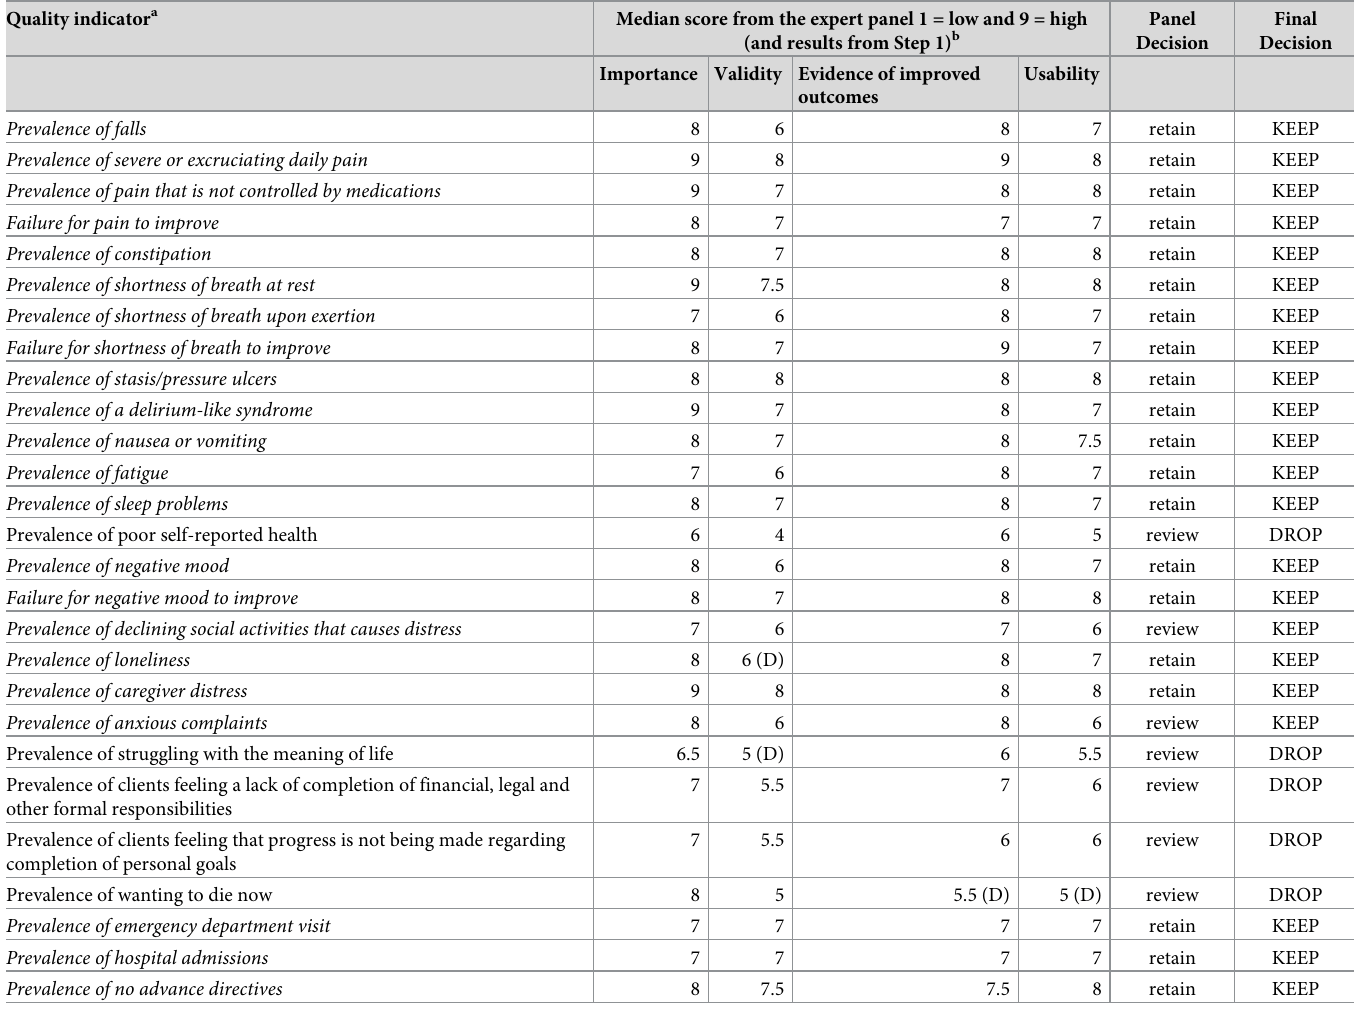
Table 3. Summary of scores from the expert panel and final decision for each of the proposed